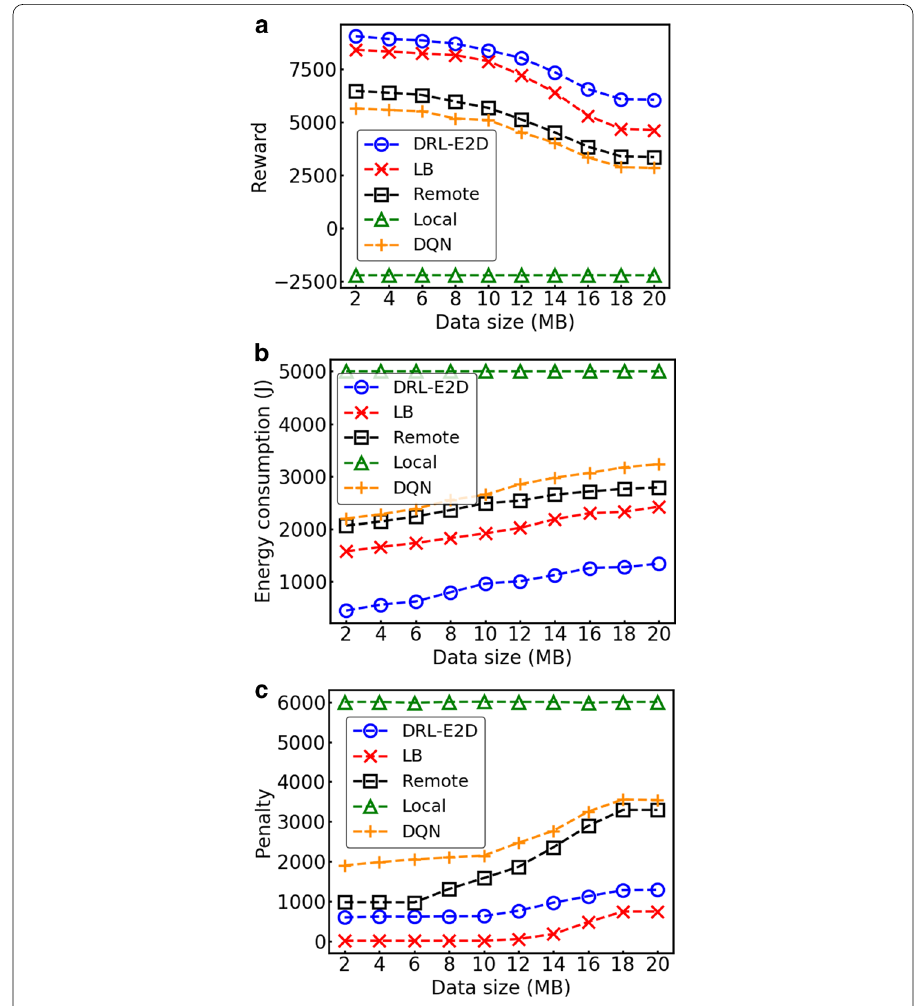
Fig. 9 The performance impact of D . a Reward. b Energy consumption. c